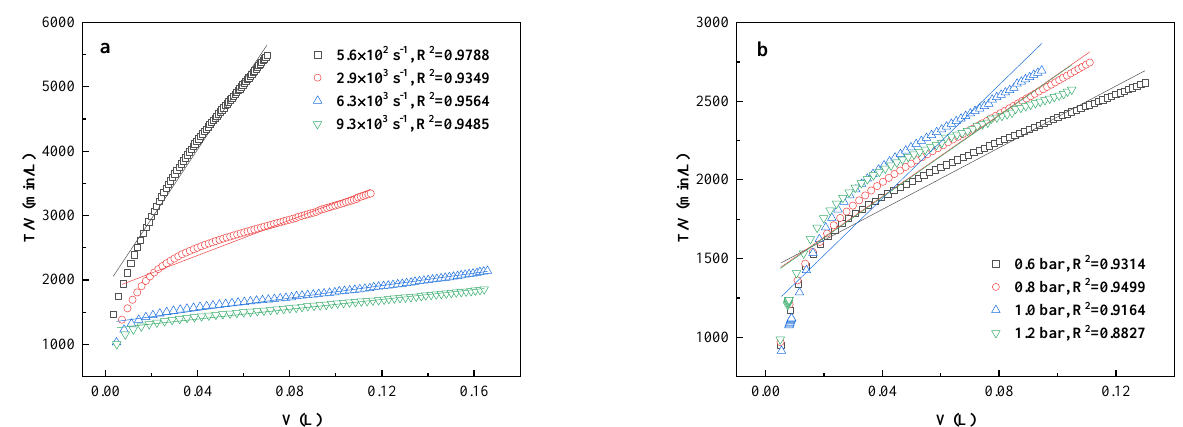
Figure 10. Data fitting of cake filtration model: ( a ) different shear rates (PVDF, TMP= 1.0 bar); ( b ) different TMP (PVDF, shear rate = 2.9 × 10 3 s − 1 ).